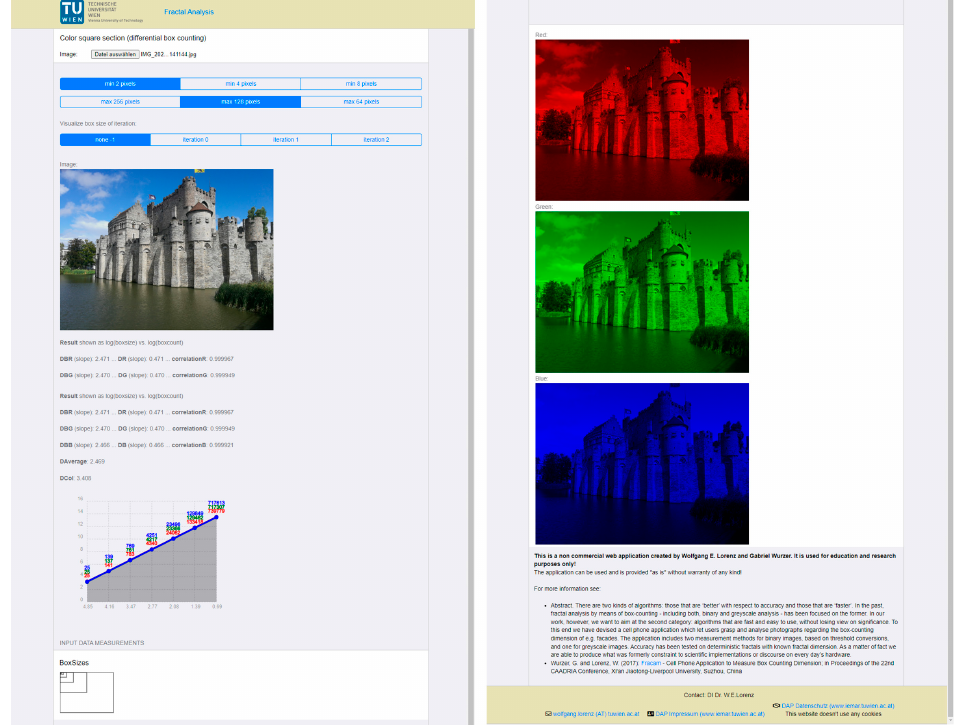
Figure 5. Differential box-counting of the web application “FRACAM”, showing the castle of Ghent, Belgium. ( Left top , left middle ): results, with D Red = 0.471, D Green = 0.470, and D Blue = 0.466; with Correlation Red = 0.471, Correlation Green = 0.999949, and Correlation Blue = 0.999921; D Average = 2.469; D col = 3.408; ( left bottom ): used box sizes; ( right side ): RGB